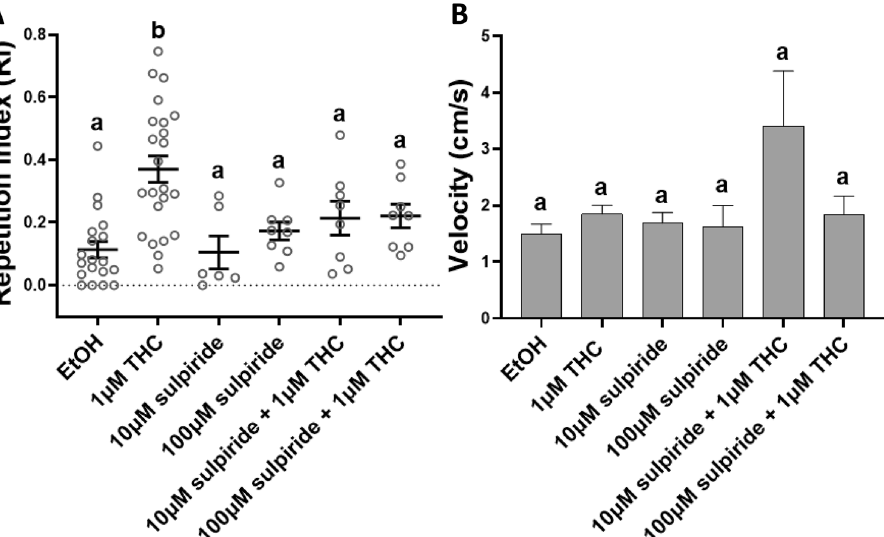
Figure 6. Co-administration of Tetrahydrocannabinol (THC) and the atypical antipsychotic sulpiride significantly reduced the THC-induced behavioral stereotypy in adult zebrafish. ( A ) At 10 μM sulpiride with 1 μM THC and 100 μM sulpiride with 1 μM THC, the THC-induced Repetition Index (RI), calculated as a mean ± SEM, was not statistically different from the controls (EtOH) (ns p > 0.05). ( B ) None of the co-administrations significantly altered the swimming velocity during exposure (ns p > 0.05). Controls (EtOH) (0.0015% (n = 19)), 1 μM THC (n = 23), 10 μM sulpiride (n = 6), 100 μM sulpiride (n = 8) 10 μM sulpiride + 1 μM THC (n = 8) and 100 μM sulpiride + 1 μM THC (n = 8). Values without a letter in common are statistically different to the control condition ( p < 0.05, Kruskal–Wallis and Dunn’s multiple comparisons